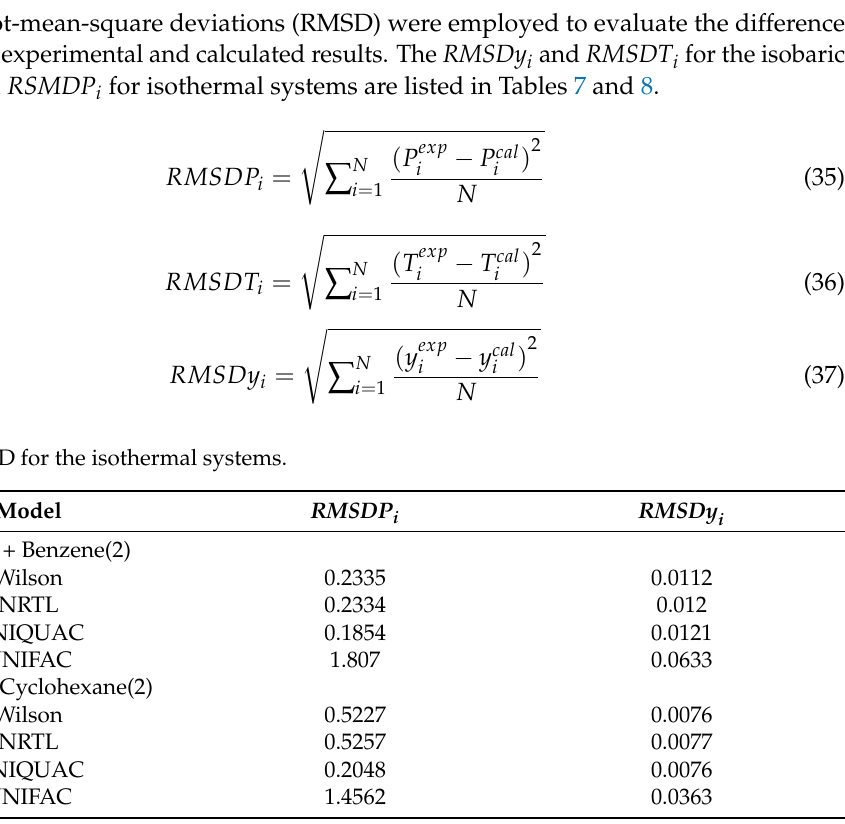
Table 8. RMSD for the isobaric system.